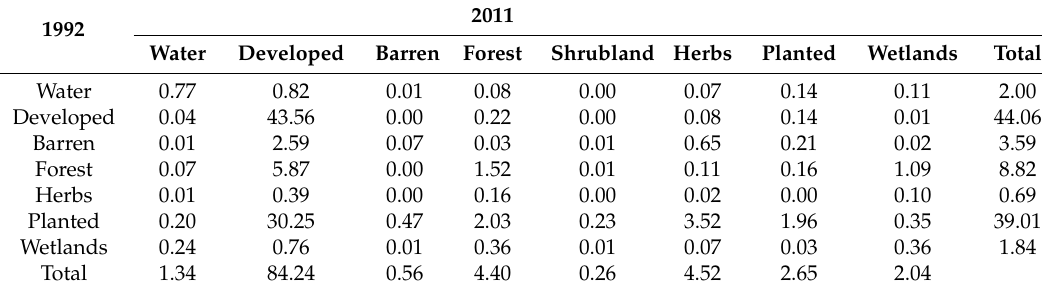
Table 6. Transition matrix (in percentages) of land use change in UWBDR from 1992 to 2011. 2011 1992 Water Developed Barren Forest Shrubland Herbs Planted